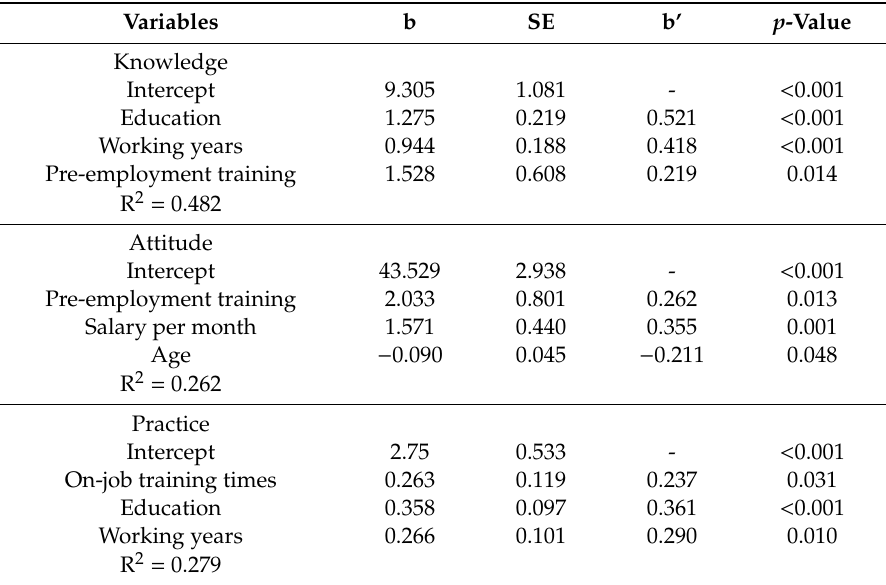
Table 5. Factors influencing knowledge, attitude, and practice.